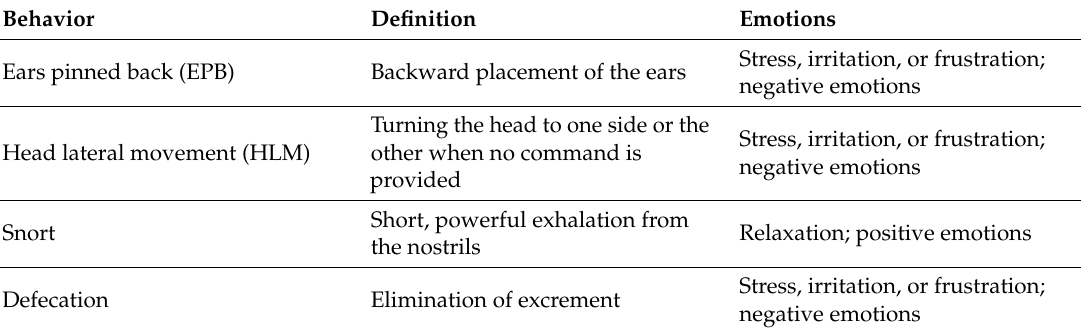
Table 2. Ethogram used for behavioral observation [14,31].